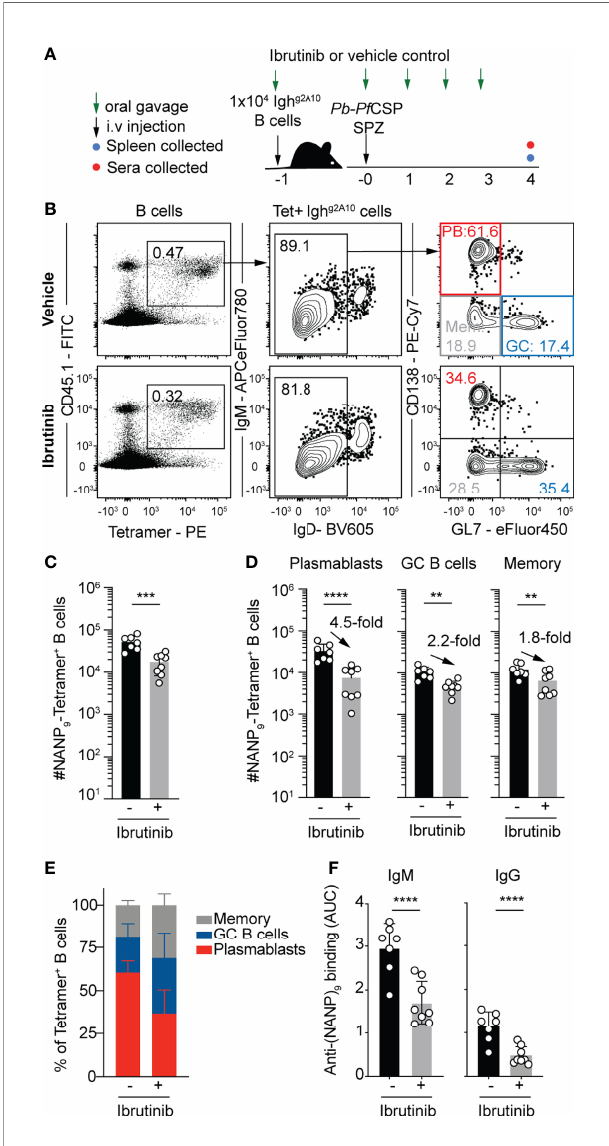
FIGURE 5 | PharmacologicallysuppressingTI-2responsessuppressesthe Pf CSP-speci fi cplasmablastresponse.1x10 4 Igh g2A10 cellsweretransferredtomice priortoimmunizationwith5x10 4 Pb-Pf CSPSPZinthepresenceorabsenceof Ibrutinibtreatment,withsplenicBcellandantibodyresponsesassessedonday4 postimmunization. (A) Schematicofexperimentalstrategy. (B) Representative fl ow cytometryplotsforthegatingofIgh g2A10 Bcellsat4dayspost-immunization.Plots arepre-gateduponsinglets,Dump-negativeandBcells[CD19 + ±CD138 + ]. (C) Quanti fi cationoftotalrespondingIgh g2A10 Bcells. (D) Quanti fi cationofresponding Igh g2A10 Bcellsoftheplasmablast(PB),germinalcentre(GC)andmemory phenotype. (E) TheproportionofeachBcellphenotypeasapercentageofthetotal Igh g2A10 population. (F) Serumtitresofanti- Pf CSPantibodiesatday4post- immunization,quanti fi edbyELISAandpresentedasareaunderthecurve(AUC). Datafromtwoindependentexperiments,with3-4micepergroup.Statistical analysisperformedbylinearmixedmodel,withdifferentexperimentsaccountedfor asablockingfactorforrandomeffects.Abbreviationsforpvaluesare:p<0.01=**;